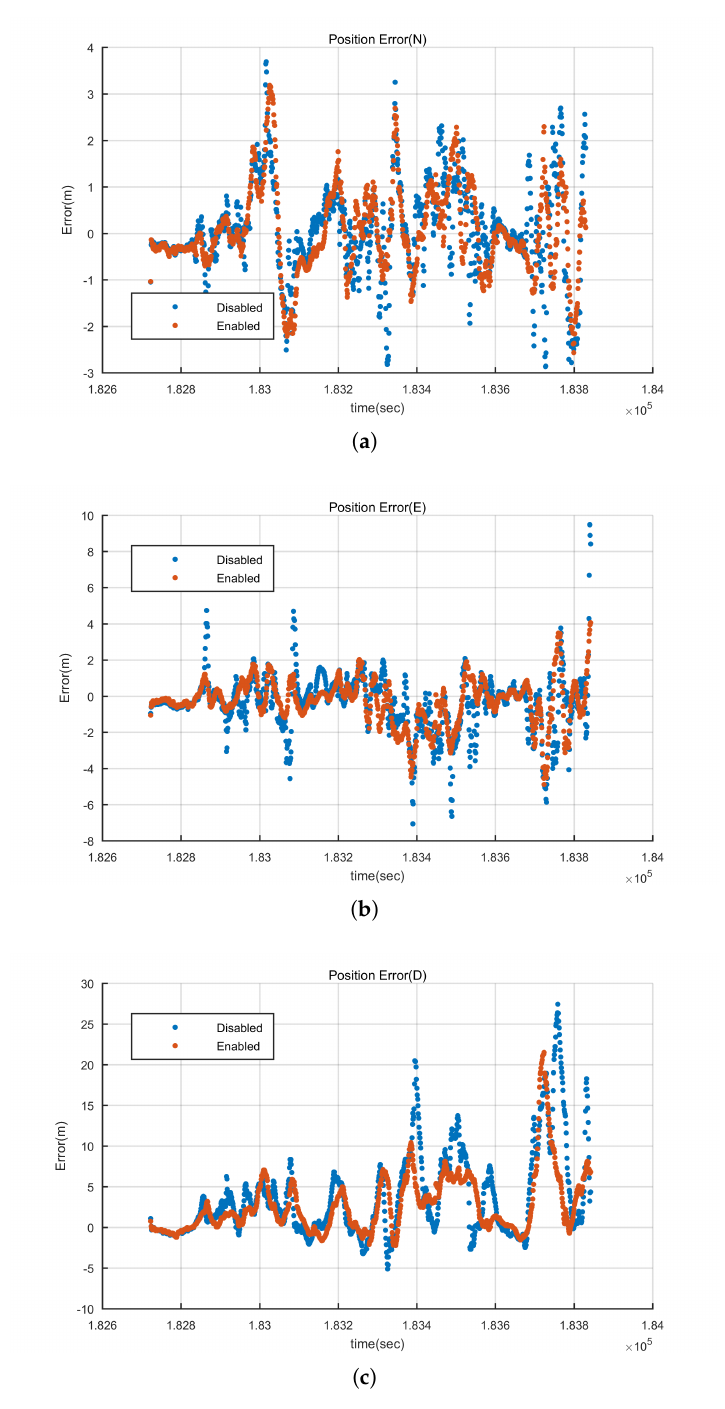
Figure 17. Integration errors comparison before and after applying adaptive tracking loops and INS aided wight control algorithm. ( a ) North direction ( b ) East direction ( c )